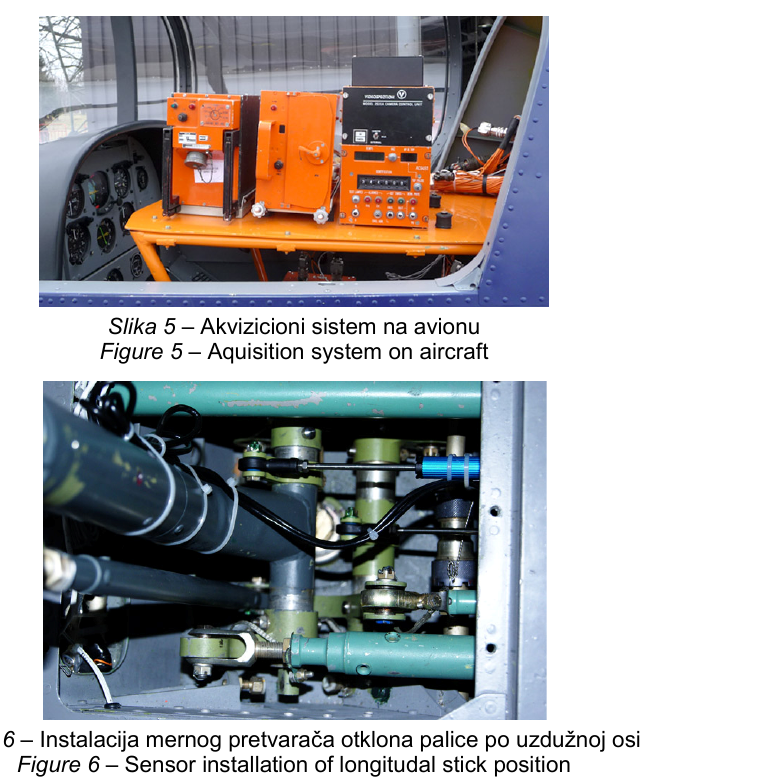
Figure 6 – Sensor installation of longitudal stick